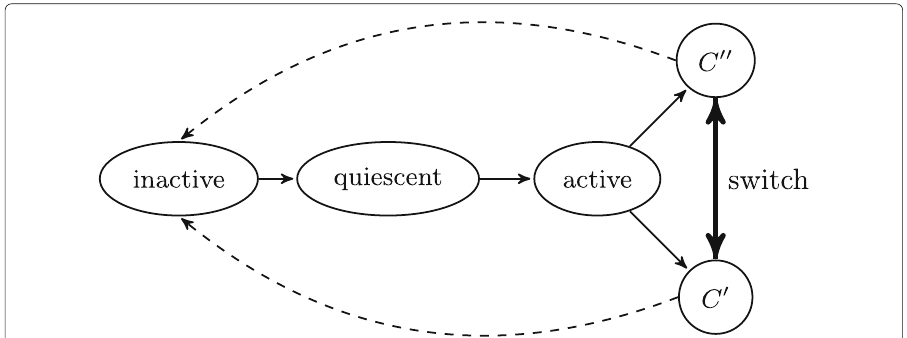
Fig. 4 Life-cycle of a node in competitive models. Straight lines represent the transitions common to both spC - F 2 DLT and npC - F 2 DLT , while dashed lines refer to npC - F 2 DLT